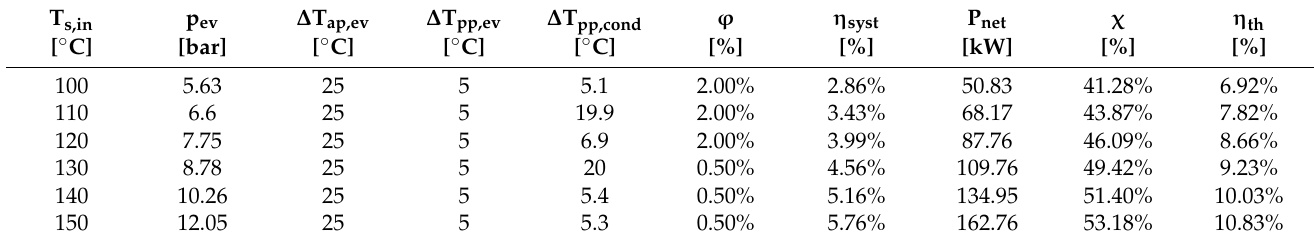
Table 4. Results of the optimization of the ORC with R245fa + MIL101 considering a theoretical double uptake ( c =